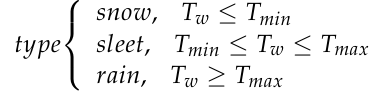
Table 1. The information on the hydrological and meteorological stations in the upper Kaidu River basin.